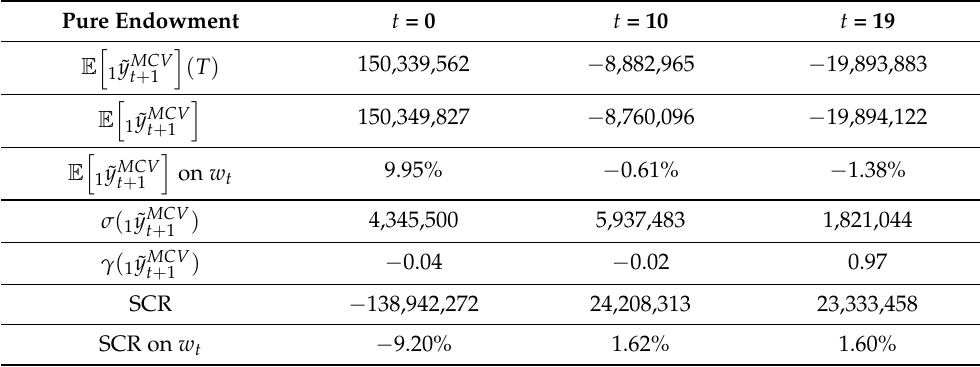
Table 4. Simulated MCV results—Pure